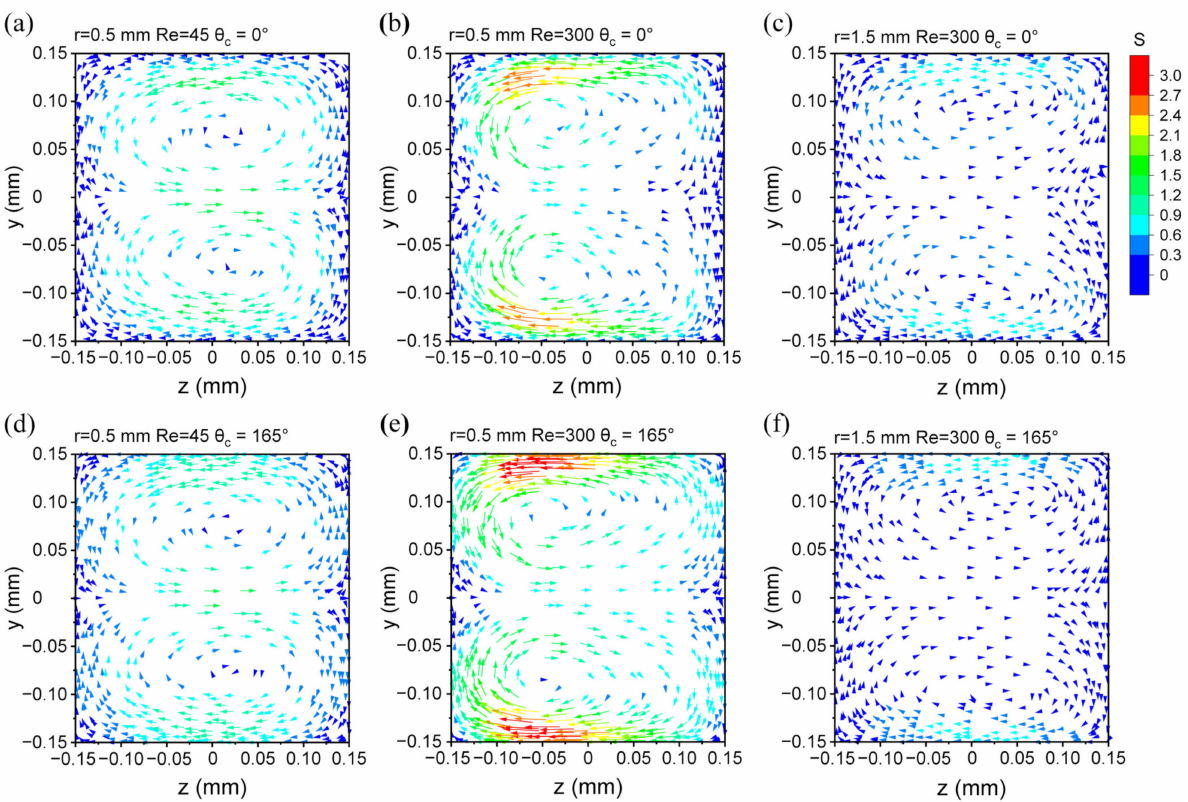
Figure 9. Secondary flow in middle cross-section: ( a ) r = 0.5 mm, Re = 45, θ c = 0, ( b ) r = 0.5 mm, Re = 300, θ c = 0, ( c ) r = 1.5 mm, Re = 300, θ c = 0, ( d ) r = 0.5 mm, Re = 45, θ c = 165 ◦ , ( e ) r = 0.5 mm, Re = 300, θ c = 165 ◦ , and ( f ) r = 1.5 mm, Re = 300, θ c = 165 ◦